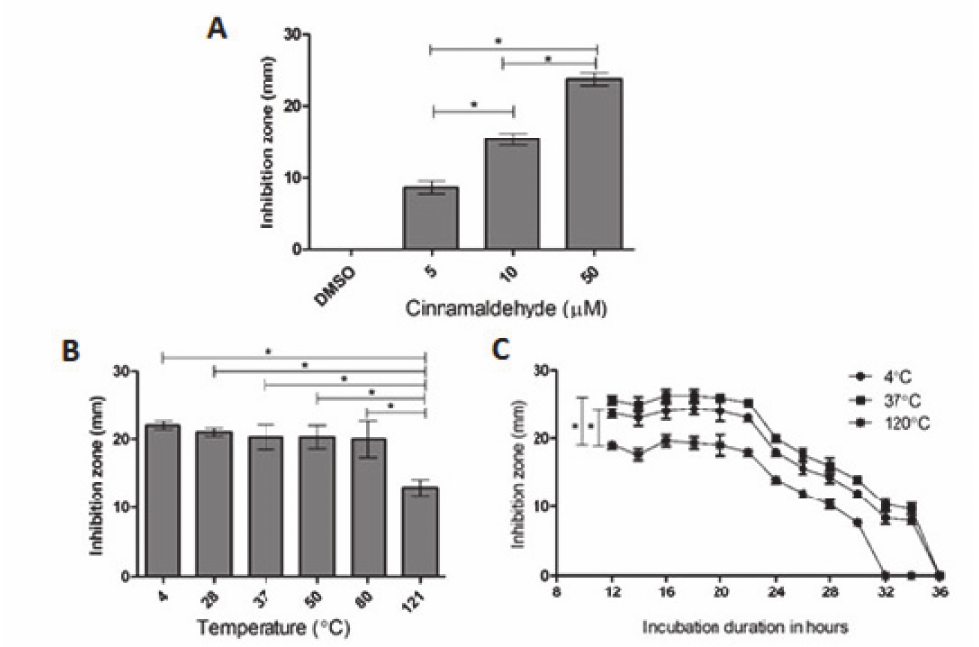
Figure 3. ( A – C ) Representative Klebsiella pneumoniae HDC inhibitory activity by cinnamaldehyde (CA). ( A ) Zones of inhibition, as measured on plates in millimeters (mm) after 12 h. ( B ) E ff ect of temperature on the CA inhibitory e ff ects from (4–121 ◦ C) of zones of inhibition (mm), as determined by the plate inhibitory method. ( C ) CA inhibition measured from 0 to 36 h at a concentration of 50 µ M. Inhibitory zone was measured using a regression plot. Data are presented as the mean ± S.D. of three independent replicate experiments. Significance were expressed as * p <